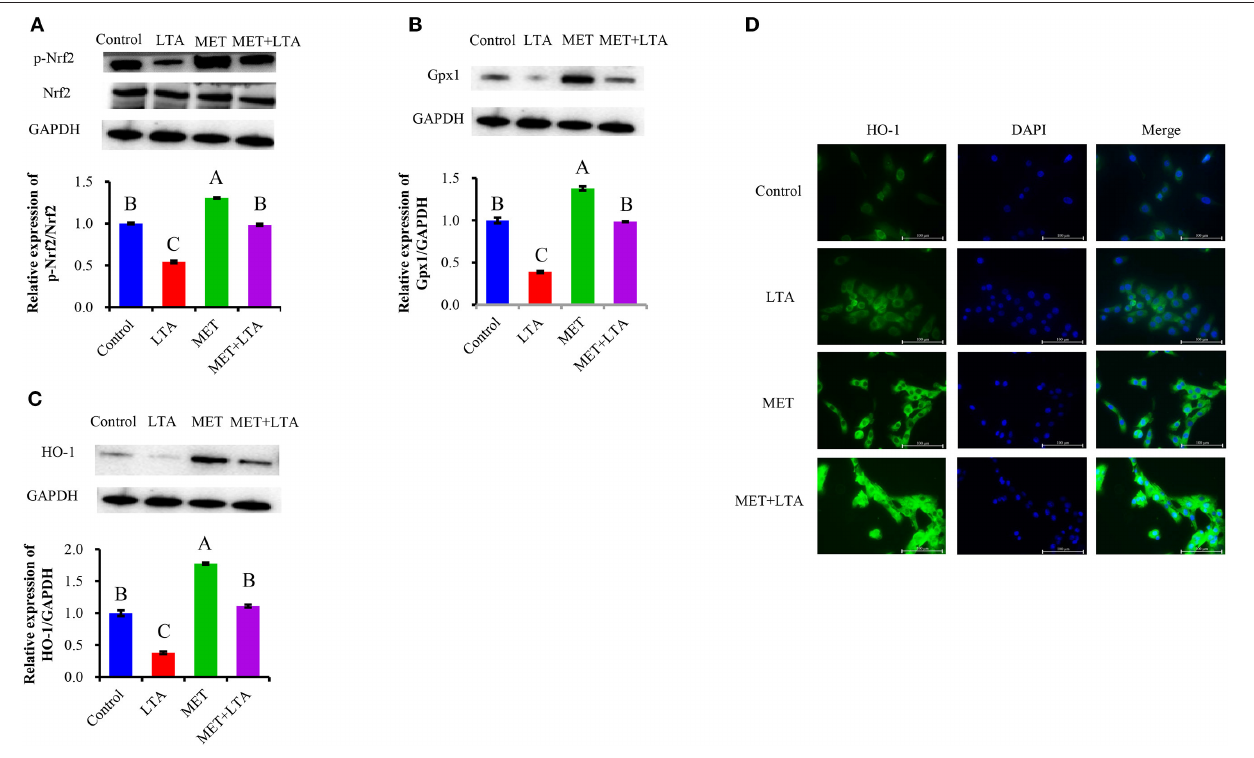
FIGURE 5 | Antioxidative effect of metformin in cells induced by LTA challenge. The expression of Nrf2 signaling–related proteins were measured by Western blot analysis in PBMECs pretreated with 3mM metformin for 12h and challenged with 100 µ L/mL LTA for 6h. The study measured the NRF2 (A) and its downstream Gpx1 (B) and HO-1 (C) protein expression. GAPDH was used to normalize the protein expression. Immunofluorescence analysis for HO-1 (FITC) was performed to visualize HO-1 (green), and the nuclear was stained with dye DAPI (blue). (D) Immunoblots and acquisition of intensity from the respective blots. Western blots shown are the representative image of three independent experiments. All results are expressed as the means ± SEM. LTA, lipoteichoic acid; MET, metformin. Different uppercase (A–C) on the top of bars indicate significant differences ( n = 3, p < 0.05) vs. among the